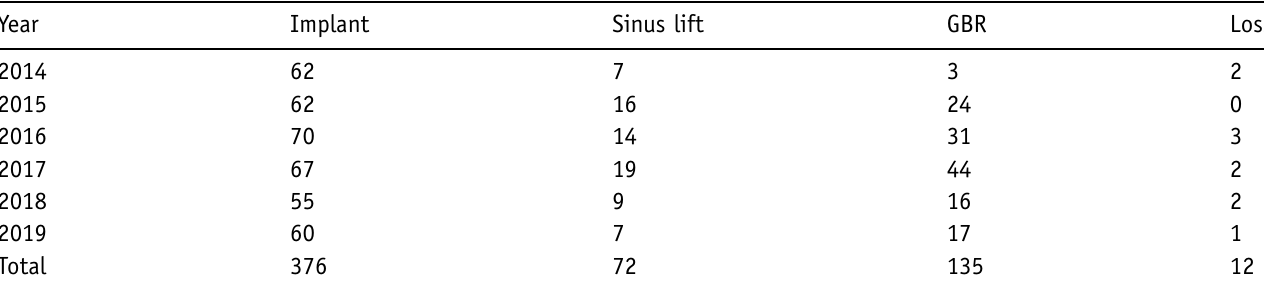
Table II. Implant and preimplant surgery activity over the 6 years follow-up.